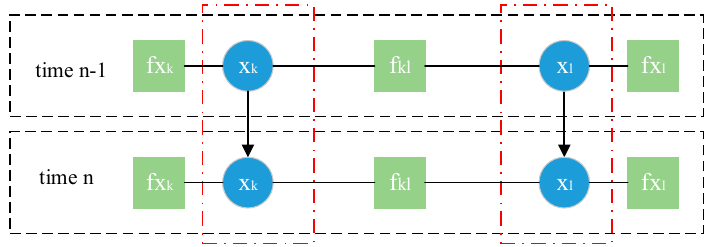
Figure 2. Factor graph showing the state of agents from time (n − 1) to time n.